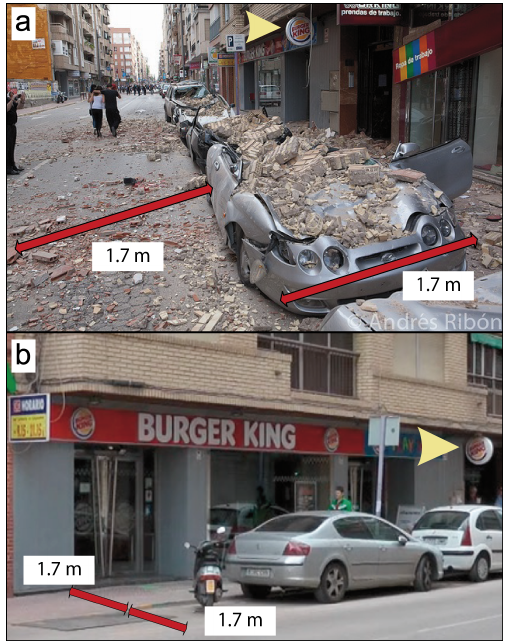
Figure 4. An example of how maximum impact distance was cal- culated. The yellow arrow shows a common reference point for the two pictures (the round restaurant logo). Image (a) was taken a few hours after the earthquake. Image (b) was taken 4 days after the earthquake. Photographs: (a) Andrés Ribón and (b) Marc Bertran Rojo.